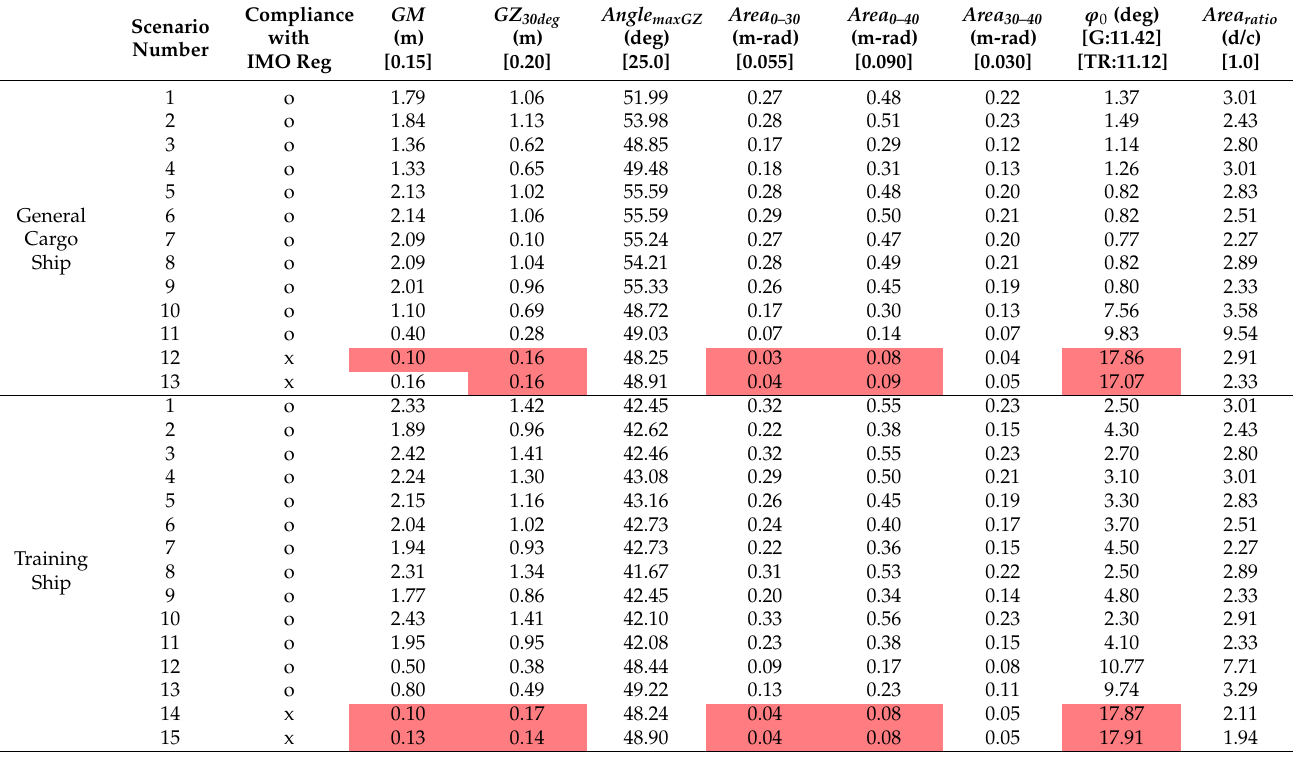
Table 7. Stability calculation using the principal